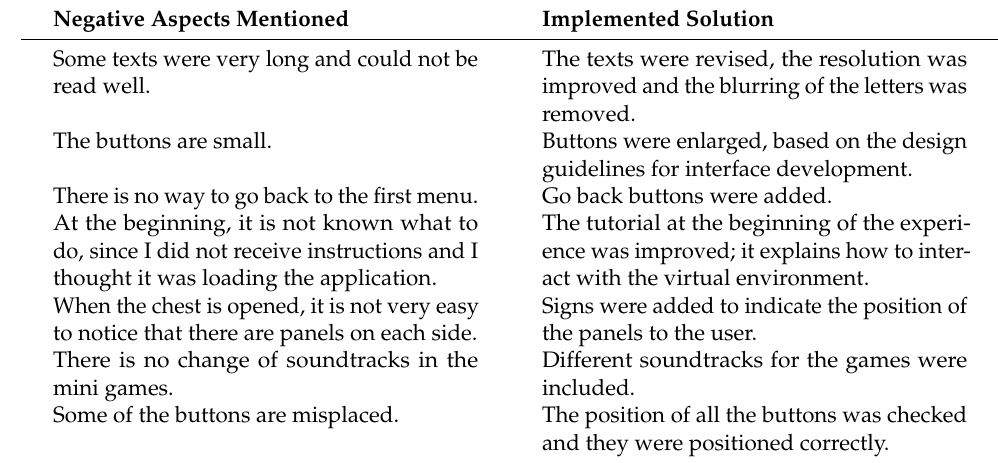
Table 3. Summary of the most relevant errors found in the study: The first column contains comments from the users about negative aspects. Although more comments were gathered, a selection of eight was made, which were the most important errors identified (most repeated, and which had the greatest impact on user experience). The second column has the solutions implemented in the final